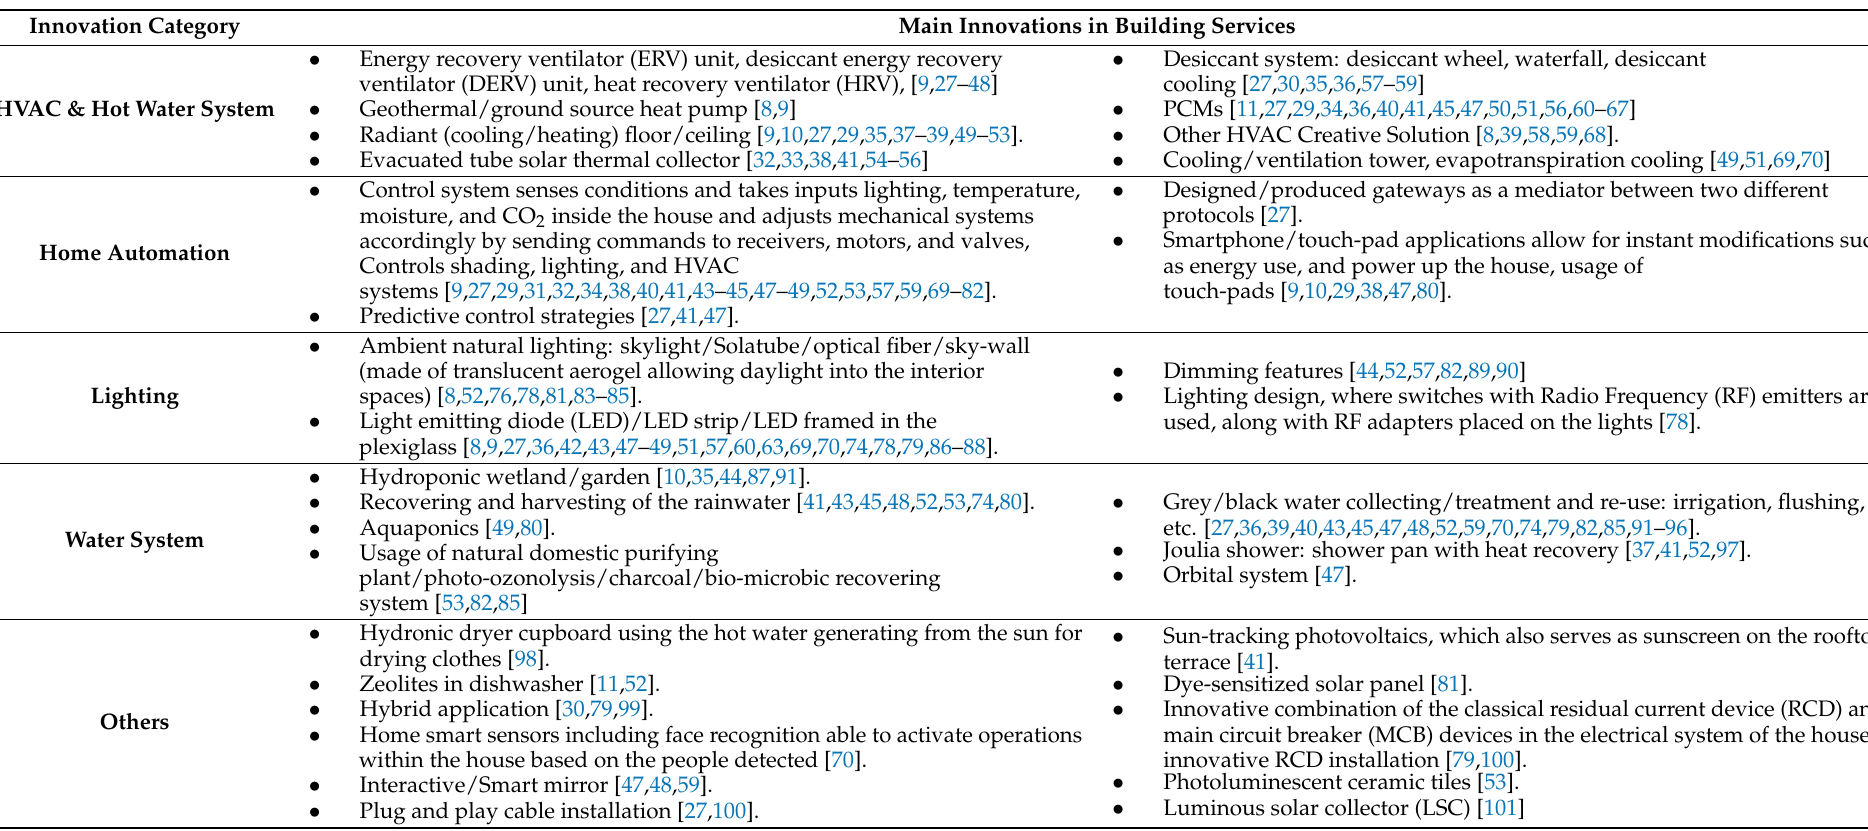
Table 2. Main innovations in building